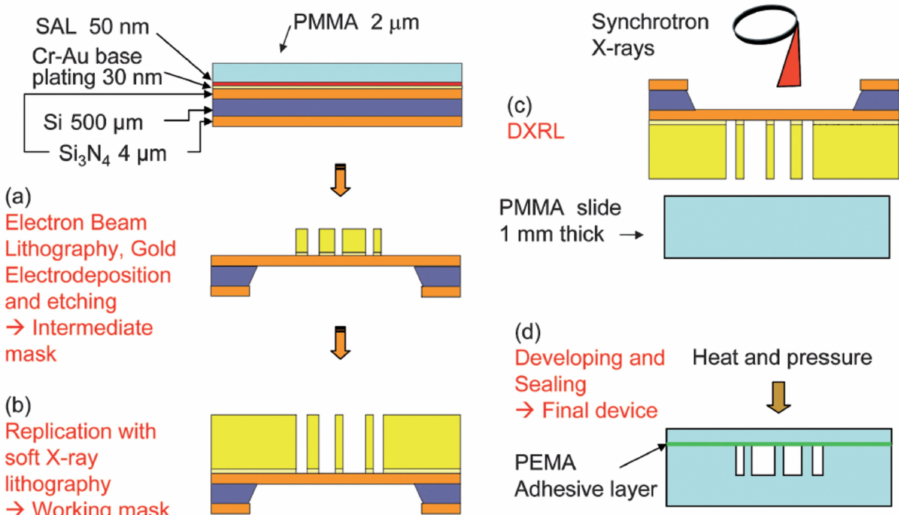
Figure 4. Schematic of the micromixer fabrication process from Marmiroli et al. [37]. ( a ) The production of an intermediate X-ray mask using Electron beam lithography, ( b ) replication of the mask by soft X-ray lithography, ( c ) fabrication of deep micromixer channels on PMMA using Deep X-Ray Lithography (DXRL), ( d ) adhesive bonding of the device. (reproduced with permission from Reference [37]).